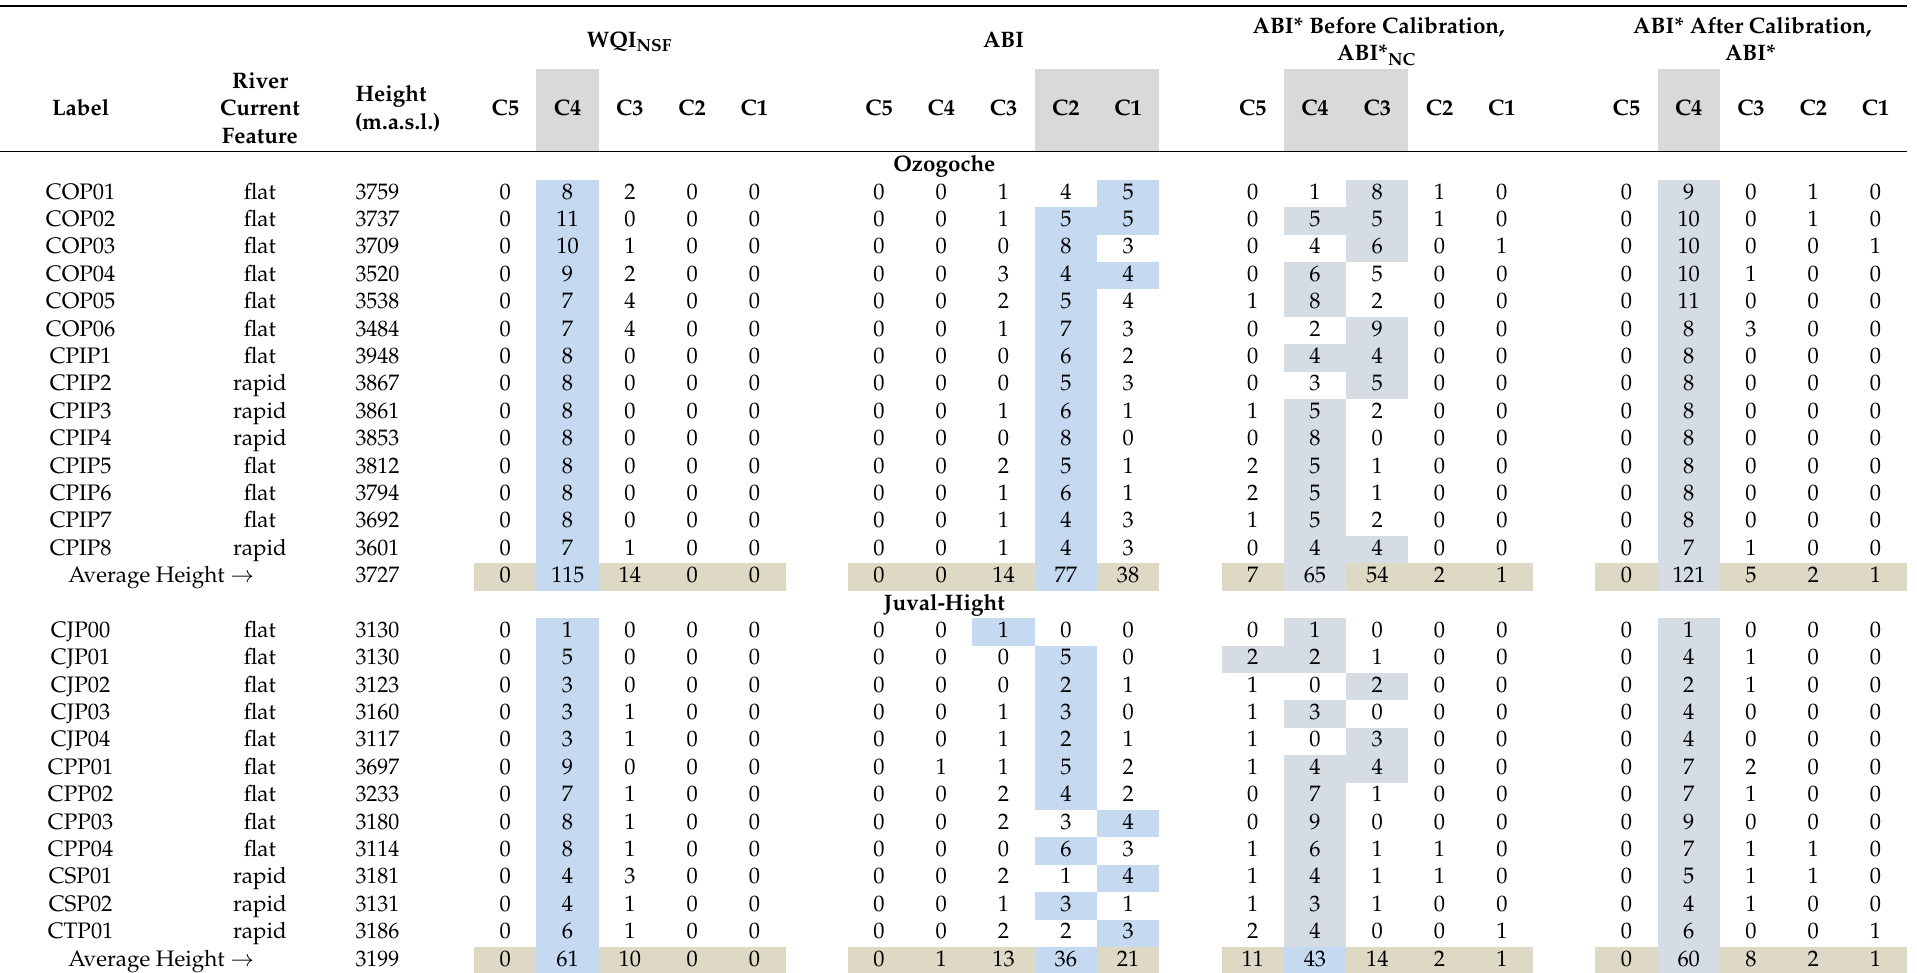
Table 8. The water quality at the 41 sampling stations and each water quality class frequency for the WQI NSF , ABI, ABI* NC before calibration, and ABI* after calibration. At station COP01, the water quality measured by WQI NSF was eight times in the C4 class and twice in the C3 class. WQI NSF ABI